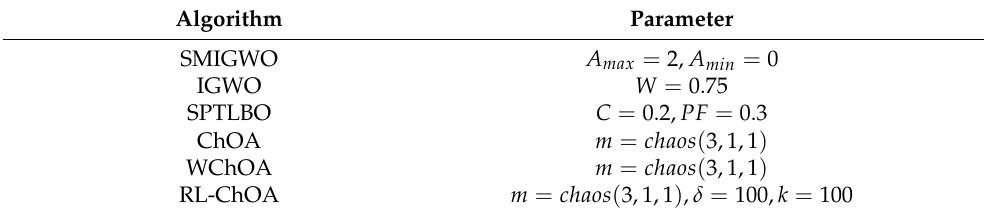
Table 1. Algorithm parameter setting.